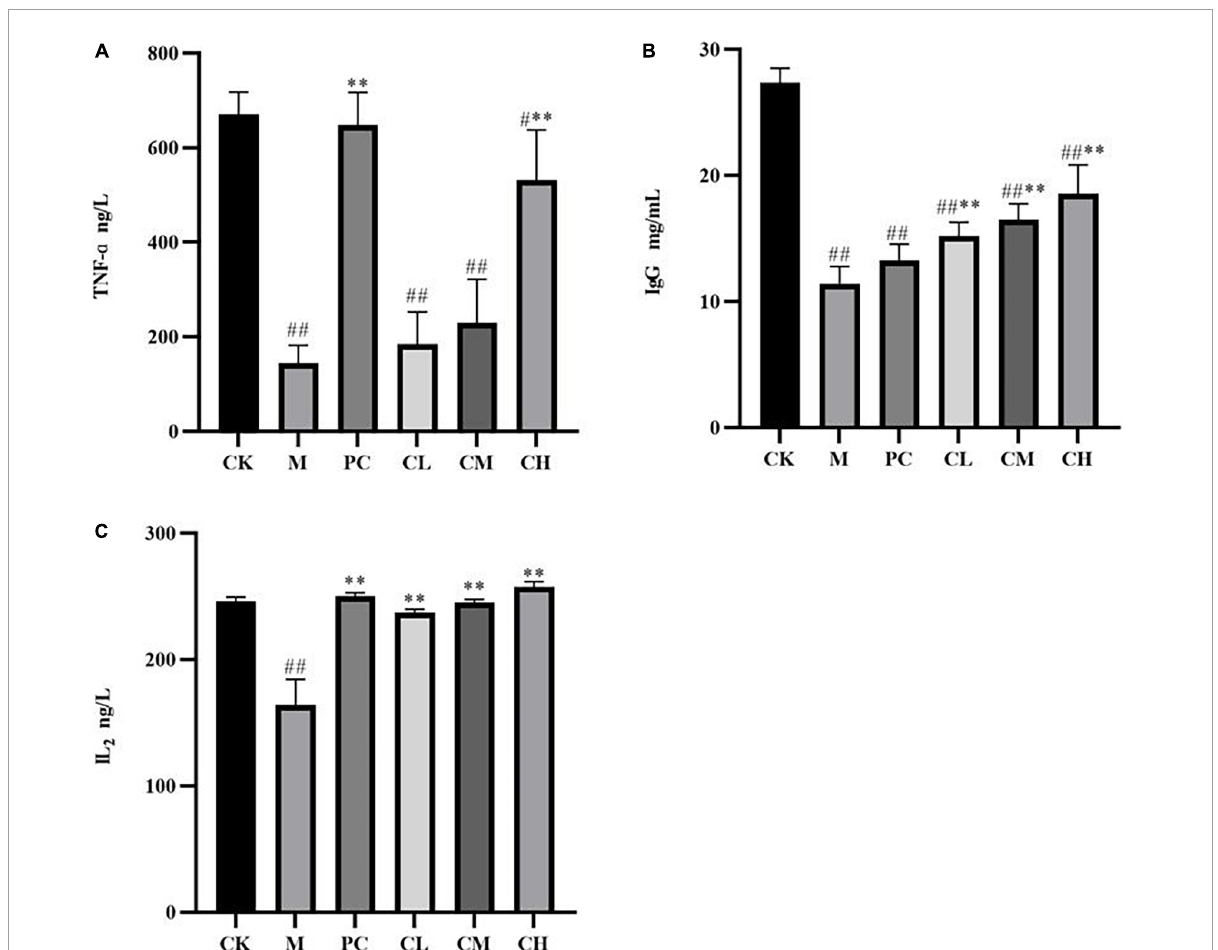
FIGURE5 Effect of samples on serum TNF- α (A) , IgG (B) , and IL2 (C) levels in mice (Compared with the M group, * indicates P < 0.05, ** indicates P < 0.01; compared with the CK group, # indicates P < 0.05, ## indicates P < 0.01).